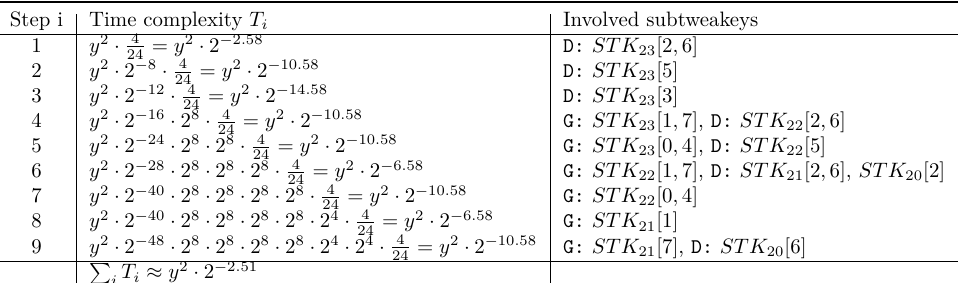
Table 9: Time complexity and guessed subtweakeys of each step in the tweakey recovery process for 24-round SKINNY-64-128 . D: deduced key cells; G: guessed key cells. Step i Time complexity T Involved i